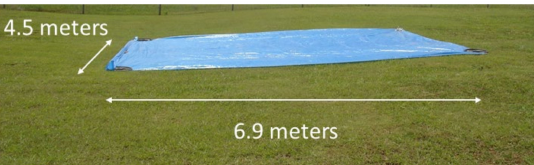
Figure 1. Blue tarp used for calibration test; photograph at SGP site.